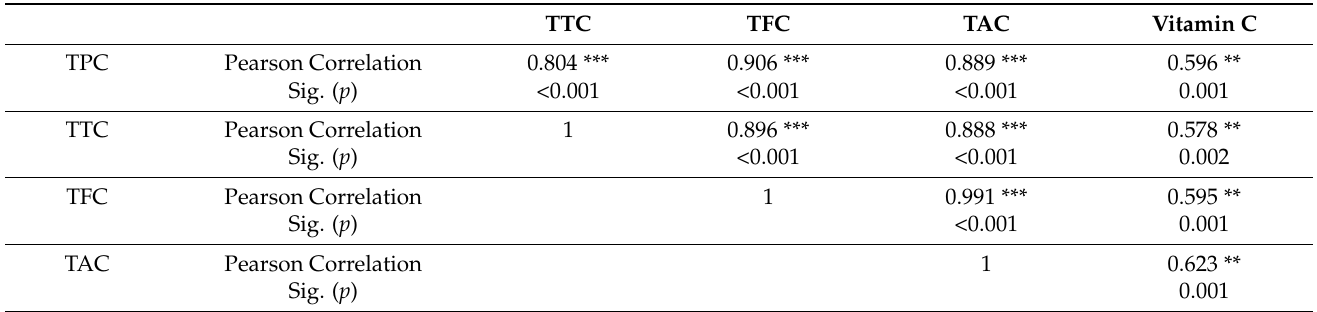
Table 3. Correlation matrix for honeyberry total phenolic (TPC), tannin (TTC), flavonoid (TFC), anthocyanin (TAC), and vitamin C.